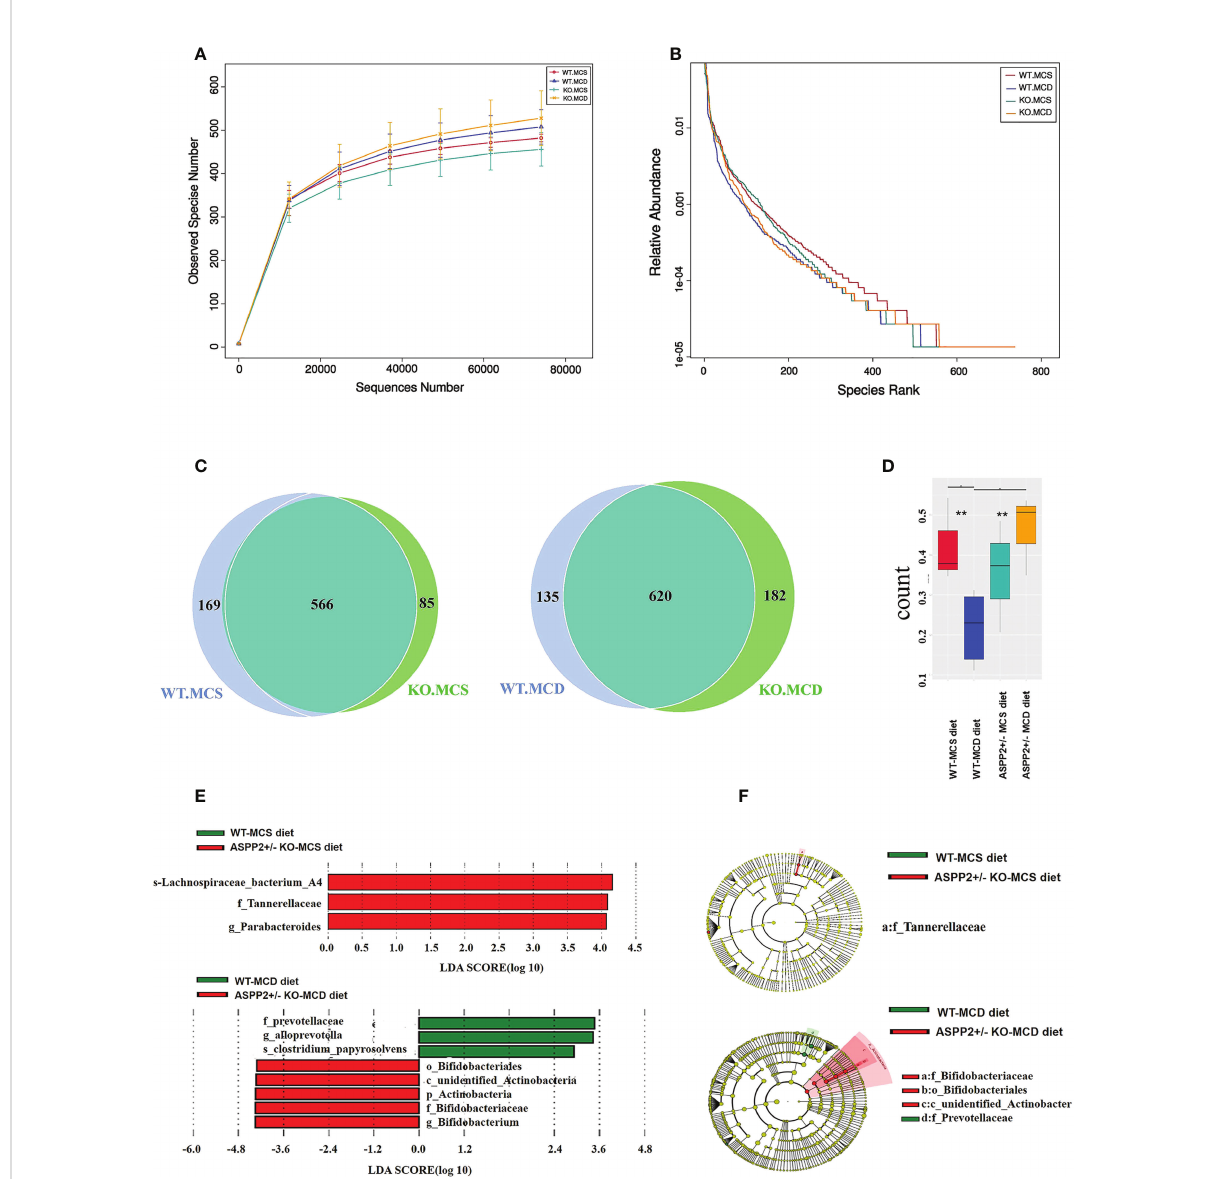
FIGURE 4 Changes of gut microbiota abundance and diversity induced by MCD or MCS diet for 10 days. (A, B) alpha-diversity of gut microbiota based on the OTU data(observer species number and relative abundance. (C) Venn diagram (WT-MCS vs ASPP2 +/ – MCS; WT-MCD vs ASPP2 +/ – MCD). (D) b -diversity in the indicated groups. (E) Histogram represents the linear discriminant analysis (LDA) scores of bacteria with signi fi cant differential abundance between WT and ASPP2 +/- mice groups induced by MCS or MCD diet identi fi ed by different colors. (F) Cladogram represents the taxonomic tree of differentially abundant taxa. WT-MCS group, n = 3; ASPP2 +/ – MCS group, n = 3; WT-MCD, n = 4 and ASPP2 +/ – MCD, n = 3.